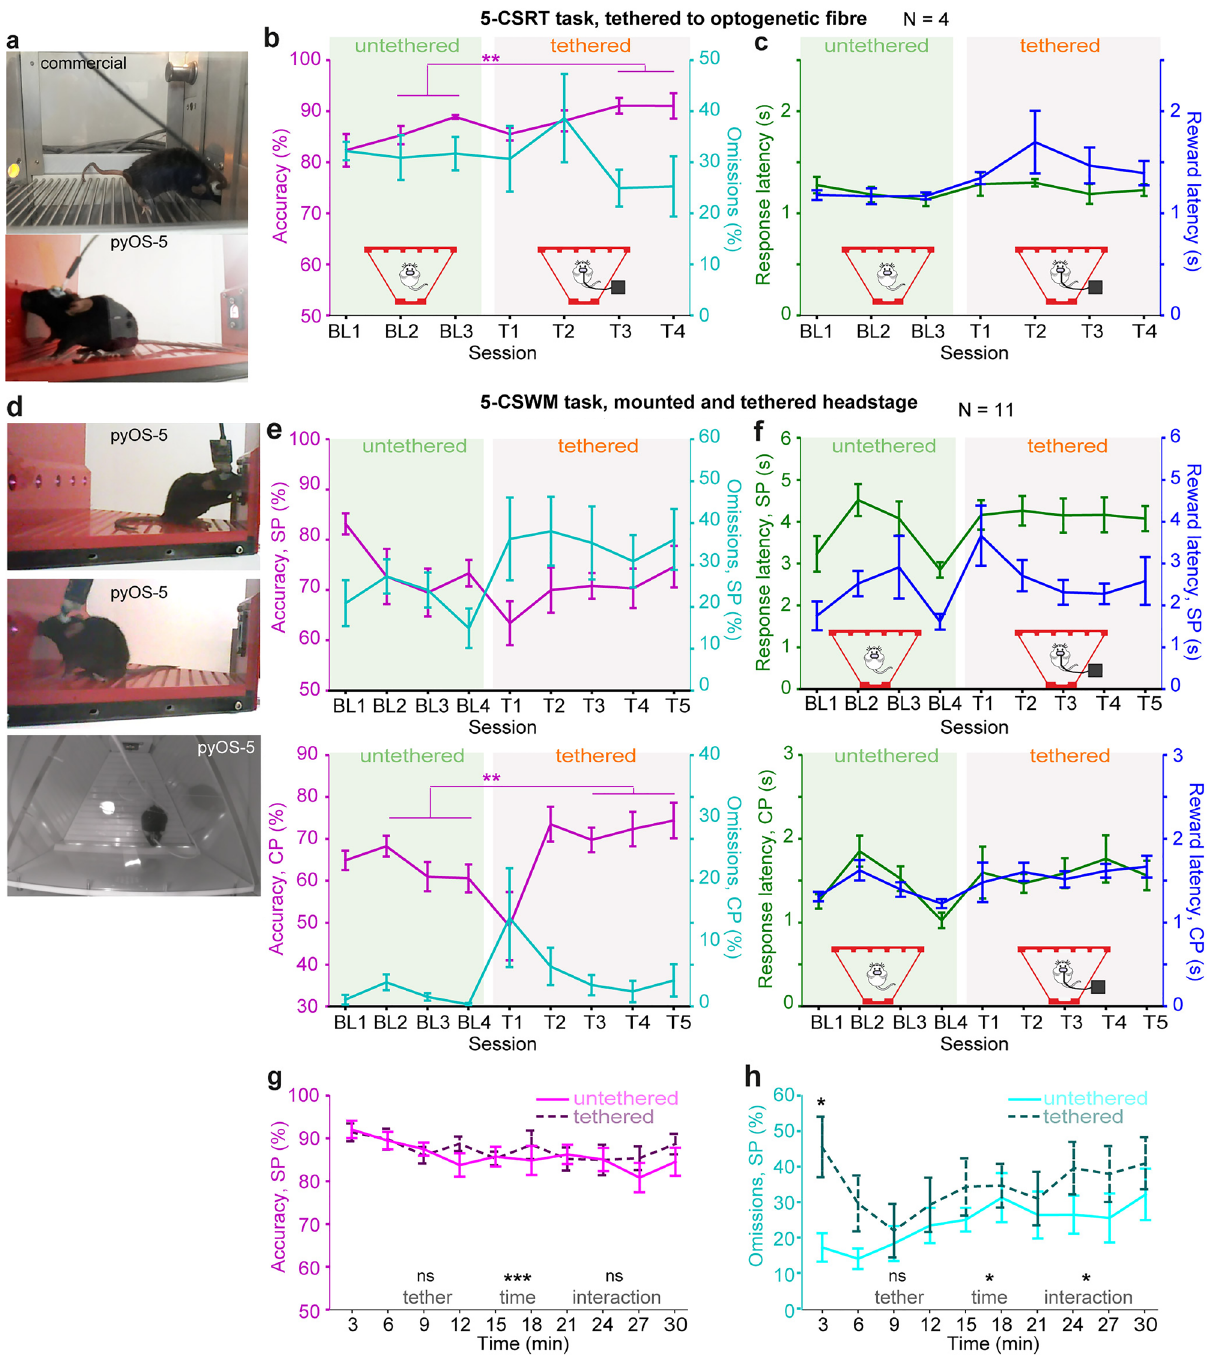
Figure 6. 5-CSRTT performance under tethered condition. ( a ) Mouse implanted with a fibre-optic cannula and tethered to a fibre patch cord collecting reward from the receptacle of a commercial operant box (top) or poking into 5-choice wall in a pyOS-5 box (bottom). ( b,c ) 5-CSRTT performance parameters in untethered (BL1–3) and tethered (T1–T4) training in consecutive sessions indicating similar or higher levels of attentional accuracy ( b , purple), task participation measured by omission rates ( b , cyan), mean duration to respond to the correct illumination, response latency ( c , green), and duration to reach the reward receptacle after a correct response, reward latency ( c , blue), if comparing the average of the last 2 days under each condition (paired t- test). ( d ) Mouse implanted and tethered via a headstage and SPI-cable collecting reward (top), poking into a 5-choice hole (middle) and waiting in front of the 5-choice wall (bottom) of a pyOS-5 box. ( e,f ) 5-CSWM task performance parameters from the sample phase (SP, top) and choice phase (CP, bottom), as stated on colour-coded y-axes, during consecutive training sessions conducted untethered (BL1–4) or tethered (T1– T5) showing similar or higher performance in the tethered state when comparing the averages of the last 3 days under each condition (paired t -test). ( g,h ) Averaged SP-data from the last three 5-CSWMT sessions conducted under each condition as shown in ( e,f ), BL2–4 and T3–5, calculated in 3-min intervals across the session to investigate signs of fatigue. Effects stated at the bottom of each panel refer to RM-ANOVA, and asterisk above data lines shows Sidak post-hoc comparison after significant tether-time interaction. Data shown as mean ± s.e.m. throughout. * P < 0.05, ** P < 0.01, *** P <